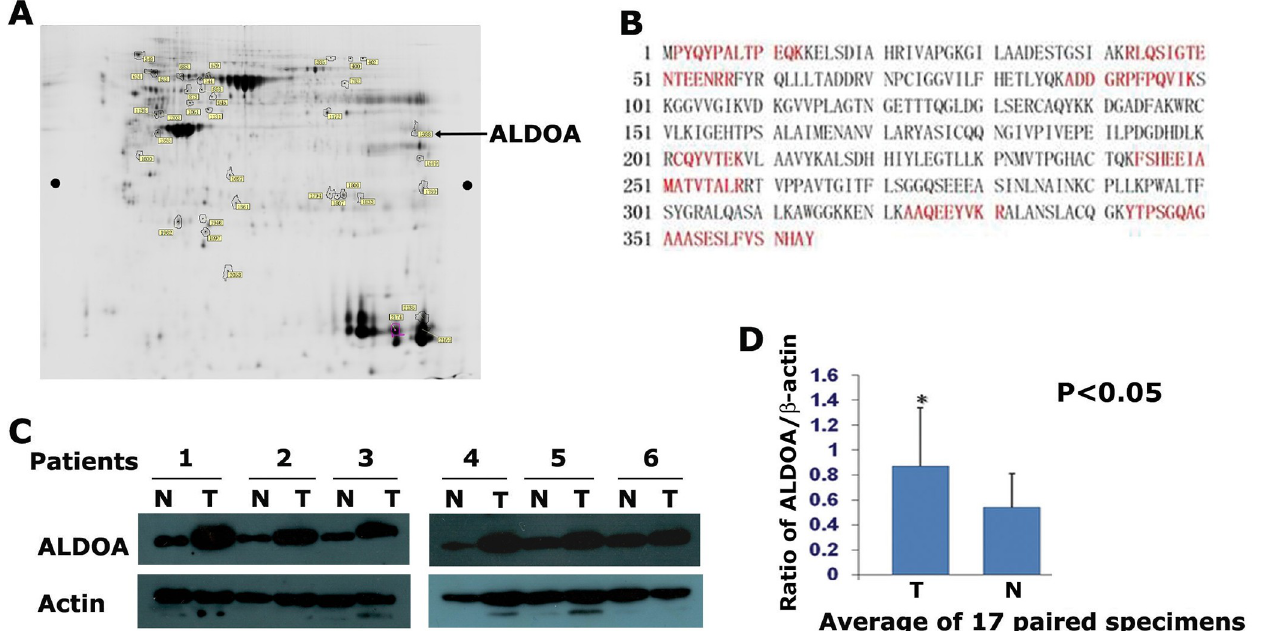
Figure 1. ALDOA is highly expressed in lung squamous carcinoma. (A) Proteomic analysis of the differentially expressed proteins from normal tissue and LSCC metastasis. Strictly selected 7 pairs of the matched LSCC specimens were subjected for 2D-DIGE and MS proteomic analysis. ALDOA was up-regulated 3.12-fold in metastatic LSCC tissues and 1.77-fold in non-metastatic LSCC tissues compared to adjacent normal tissues (the pointing arrow shows the ALDOA spots). The 2D gel electrophoresis image in Figure 1A has been replaced with a version that has software-analyzed annotation. (B) The amino acid residues highlighted in red were those detected by MS/MS analysis and counted for 36% sequence coverage of ALDOA. (C) Western blotting analysis of the ALDOA protein expression in 17 pairs of LSCC and matched adjacent normal tissues. Higher expression of ALDOA was observed in most of LSCC tissues examined. Data from 6 pairs of specimens were shown here. (D) Average of the ALDOA protein from 17 pairs of matched specimens. The relative expression values of ALDOA were 0.87 ± 0.47 in carcinoma tissues and 0.54 ± 0.27 in normal tissues. The level of Actin was used as control for normalization.